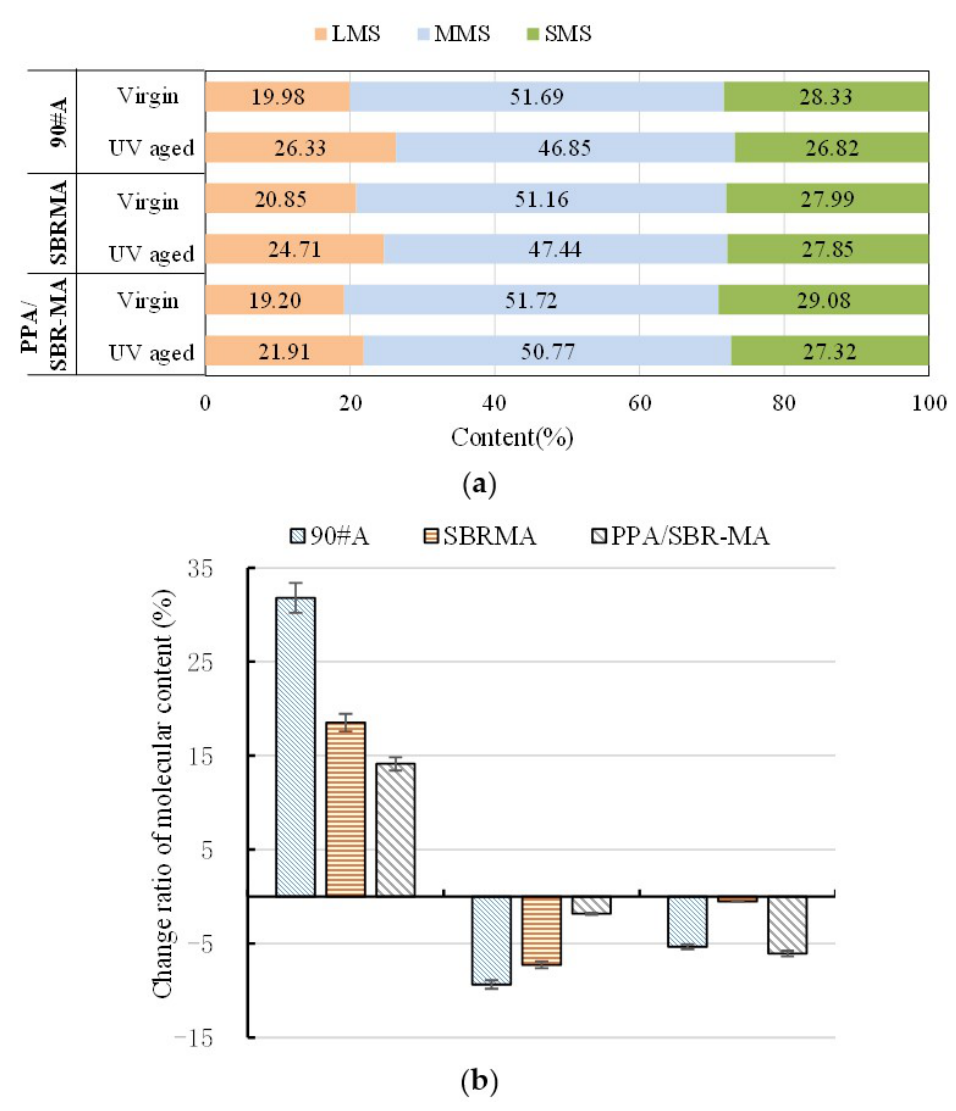
Figure 12. Molecular distribution analysis results. ( a ) Molecular distribution analysis results; ( b ) Change rate in molecular size. Table 4. Results of molecular weight